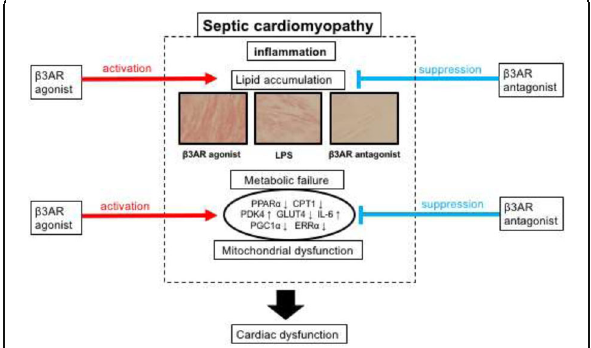
Fig. 1 (abstract 0025). The effects of beta-3 adrenergic receptor ( β 3AR) reagents for septic